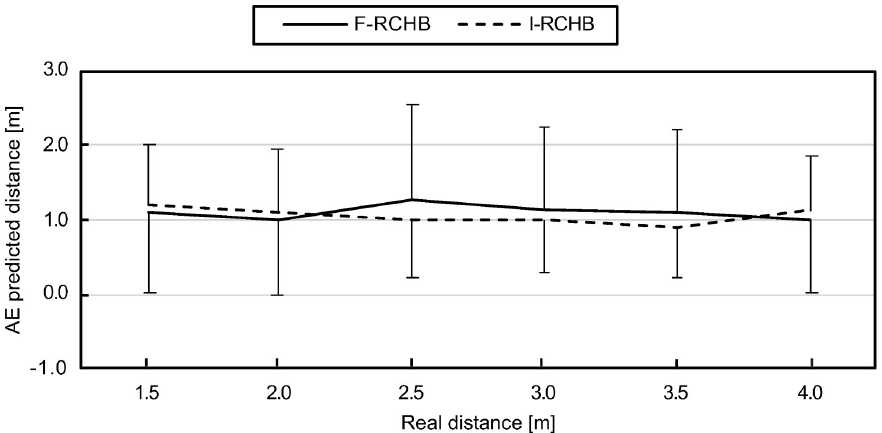
Fig 12. Absolute error. Mean and standard deviation of the absolute error of predicted putting distance under full (F-RCHB) and incomplete (I-RCHB) vision condition.